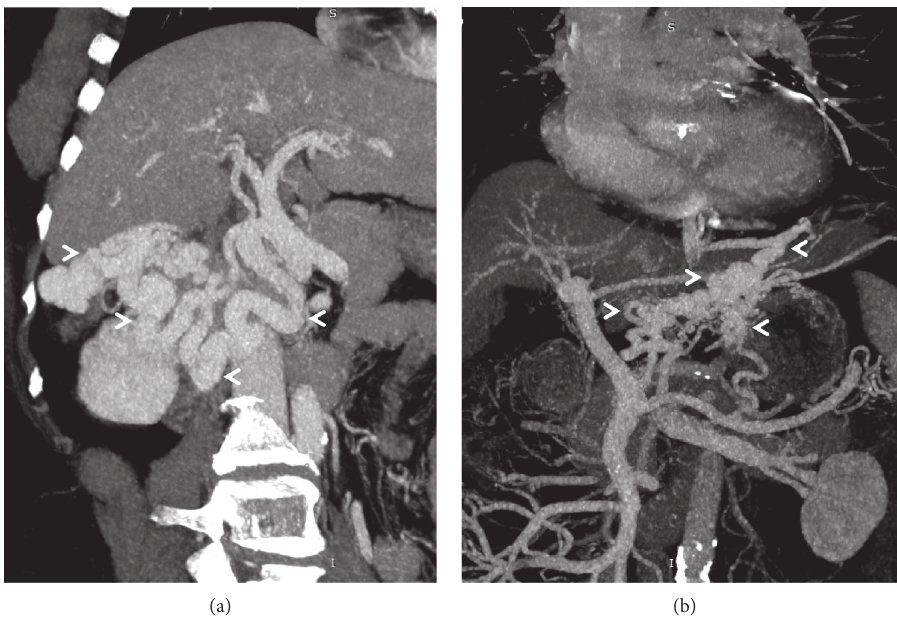
Figure 6: Coronal-oblique MIP images showing a right-sided portorenal shunt (arrowheads in (a)) and a portocaval shunt (arrowheads in